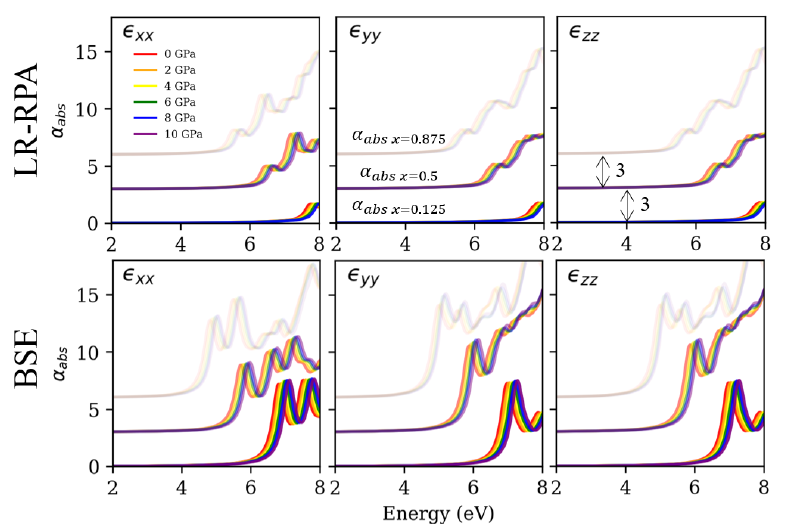
Figure 6. The frequency-dependent absorption coefficient for rocksalt (RS) Mg 1 − x Zn x O based on LR (cid:101) ( ω ) via the RPA (upper panel) and BSE (cid:101) ( ω ) (bottom panel). The first, second and third columns for each sub-figure correspond to the direction of (cid:101) xx , (cid:101) yy and (cid:101) zz , respectively. The colors red, orange, yellow, green, blue and purple correspond to 0, 2, 4, 6, 8 and 10 GPa. The dark, medium and light gray scaling express the absorption coefficient within the concentrations of 0.125, 0.5 and 0.875, respectively. Moreover, the spectrum with the different concentrations of 0.125, 0.5 and 0.875 is individually adjusted by adding the values of 0, 3, 6 to the y